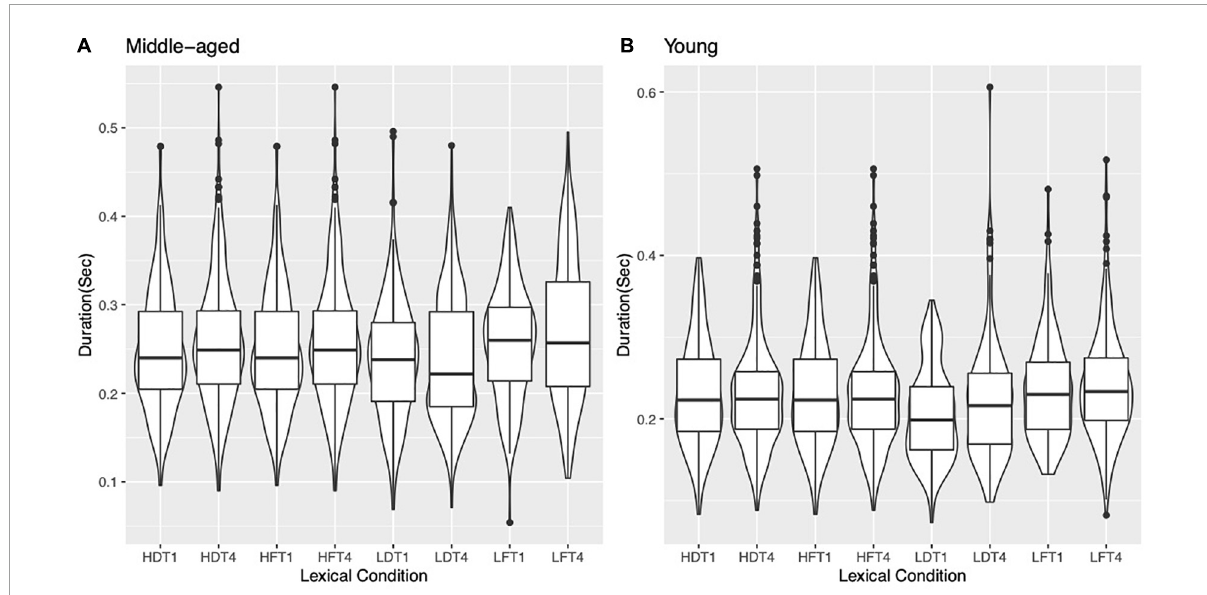
FIGURE2 Duration of the rhyme part of syllables for T1 and T4 produced by (A) 30 middle-aged participants and (B) 30 young participants in the four lexical conditions (HF, LF, HD, and LD). For example, HFT1 represents syllables with high lexical frequency in T1.